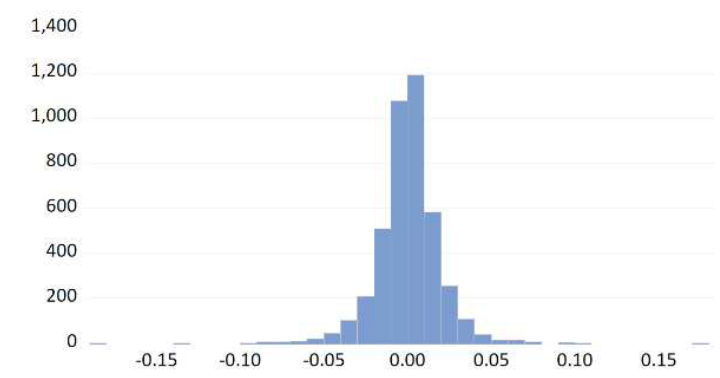
Figure 2. Histogram for Bank Nifty Index returns